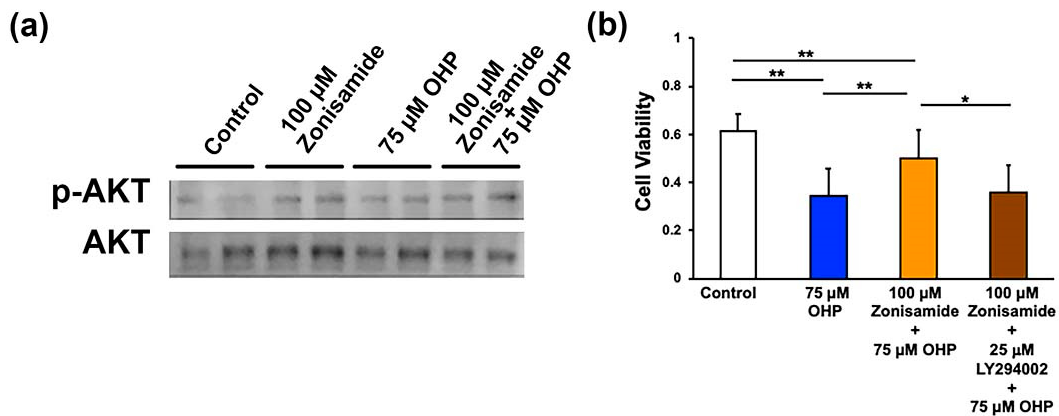
Figure 4. Involvement of the PI3K/AKT signaling pathway in the protective activity of zonisamide against OHP-induced neurotoxicity: ( a ) Preincubation with 100 μ M zonisamide for 1 h tended to upregulate the expression of phosphorylated AKT (p-AKT) in naïve ND7/23 cells, but not in the cells incubated with 75 μ M of OHP for 1 h; results referring to Western blotting. ( b ) Co-incubation with 25 μ M of LY294002 (a PI3K inhibitor) weakens the alleviating effects of zonisamide (100 μ M) against the OHP-induced (75 μ M) cell death. Data are presented as the mean ± SD of 11 experiments; **: p < 0.01; *: p < 0.05 (as defined by Tukey–Kramer).